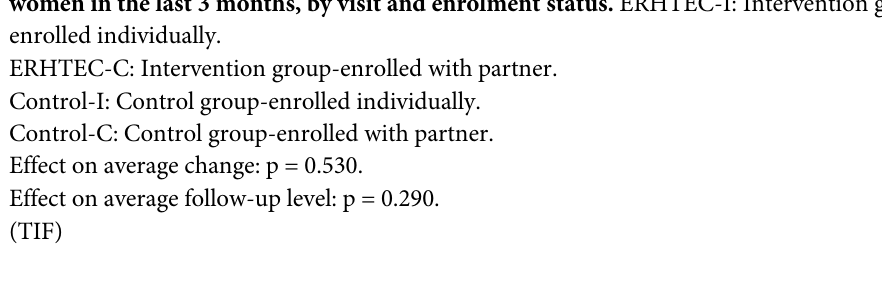
S7 Fig. Proportion of condom users at last vaginal sex among intervention and control women in the last 3 months, by visit and enrolment status. ERHTEC-I: Intervention group- enrolled